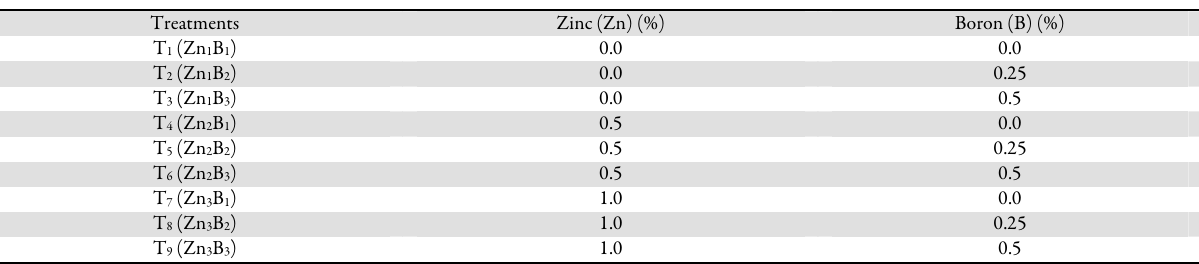
Table 1. Different doses of micronutrients (Zn and B) used as foliar spray for onion